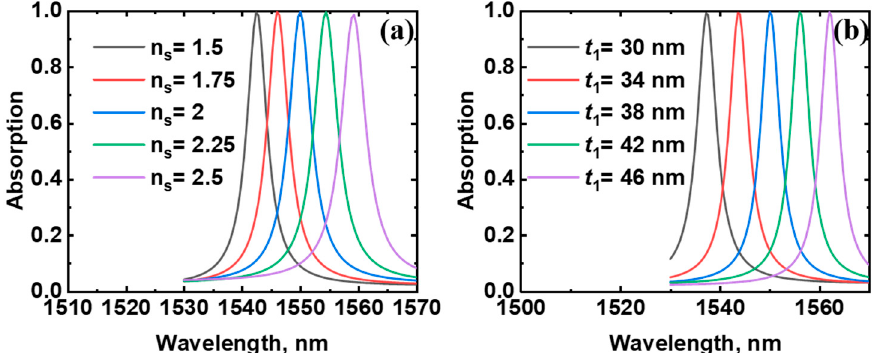
Figure 7. Absorption spectra for changing the spacer’s ( a ) refractive index ns and ( b ) thickness t1.